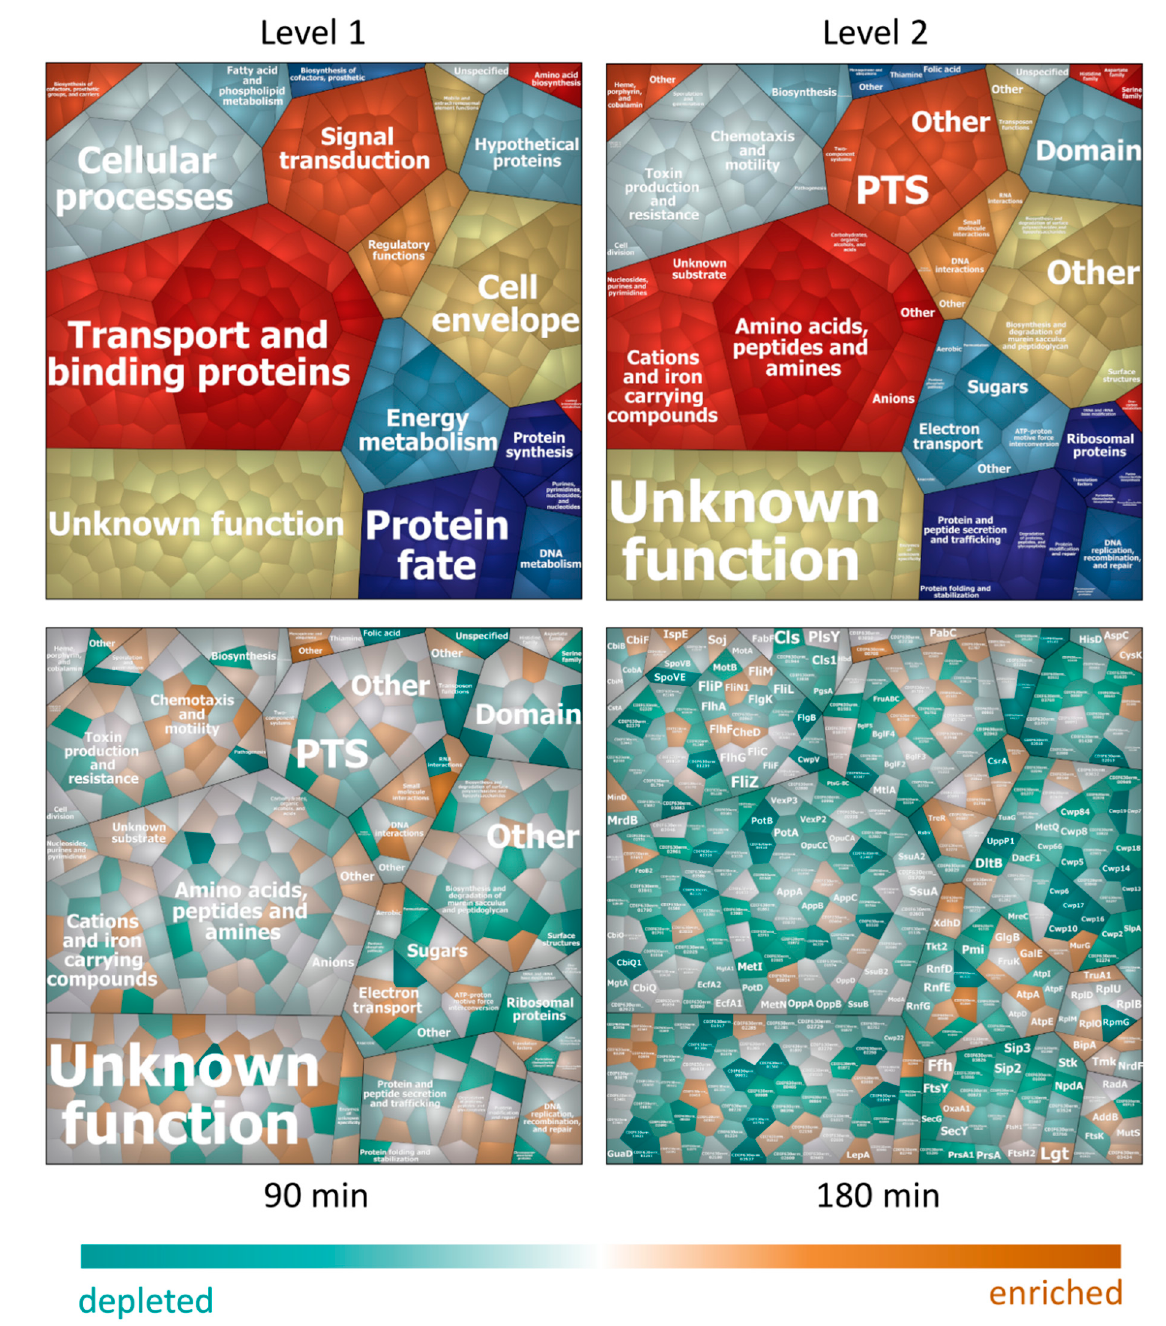
Figure 4. Voronoi Treemaps for proteins in the membrane fraction. Proteins predicted to be located in the cell membrane, the cell wall or with unknown localisation, which were quantified in the membrane fraction of all samples, are depicted in tiles and were hierarchically clustered according to TIGRFams. The upper part of the figure displays the first two cluster levels of assigned functions. The third level displaying protein names for every single tile is shown in the map for timepoint 180 min. A list of assigned functional groups to all proteins detected in the membrane fraction can be found in Supplemental Material (Supplemental Table S2). The lower part of the figures displays the relative protein abundance at 90 min ( left ) and 180 min ( right ) after nisin treatment compared to untreated control conditions, respectively. Tiles of proteins with higher abundance after nisin treatment are colored in shades of orange, tiles of proteins with lower abundance after treatment are colored in turquoise.